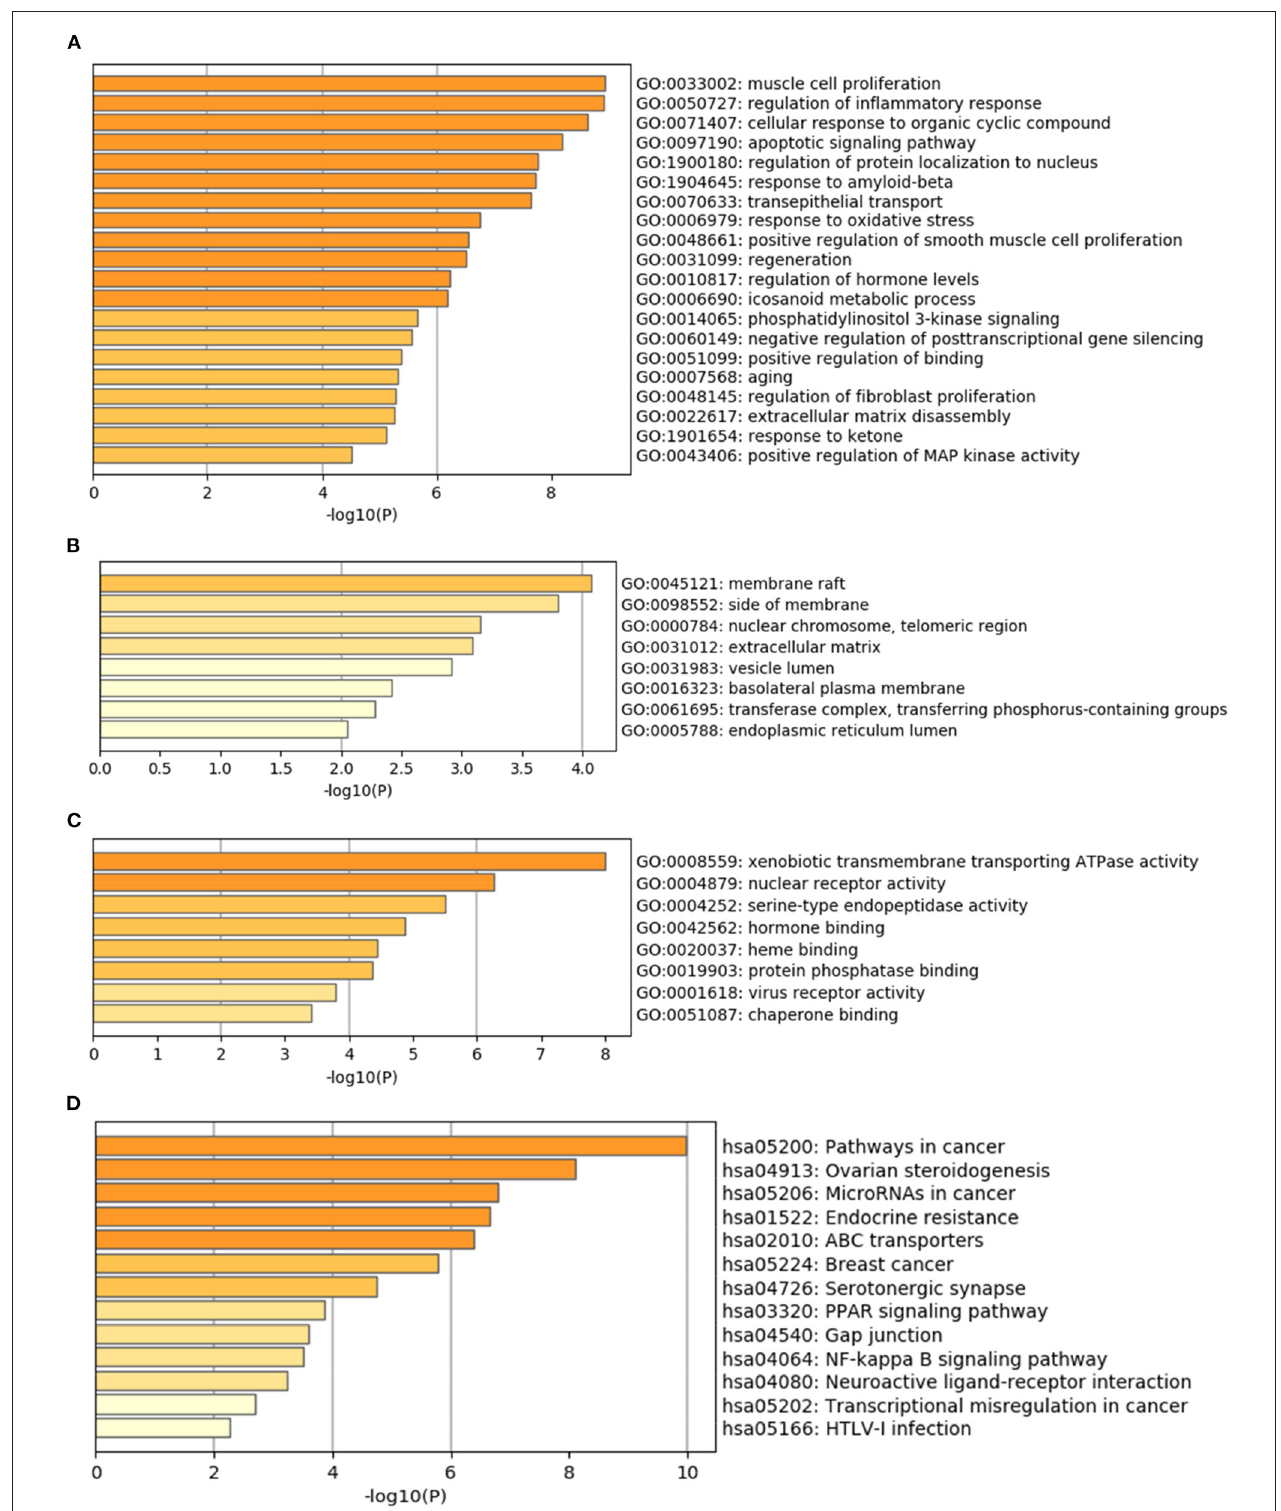
FIGURE 3 | GO and KEGG pathway enrichment analyses of 34 common target genes. (A) Biological process analysis. (B) Cellular component analysis. (C) Molecular function analysis. (D) KEGG pathway analysis.